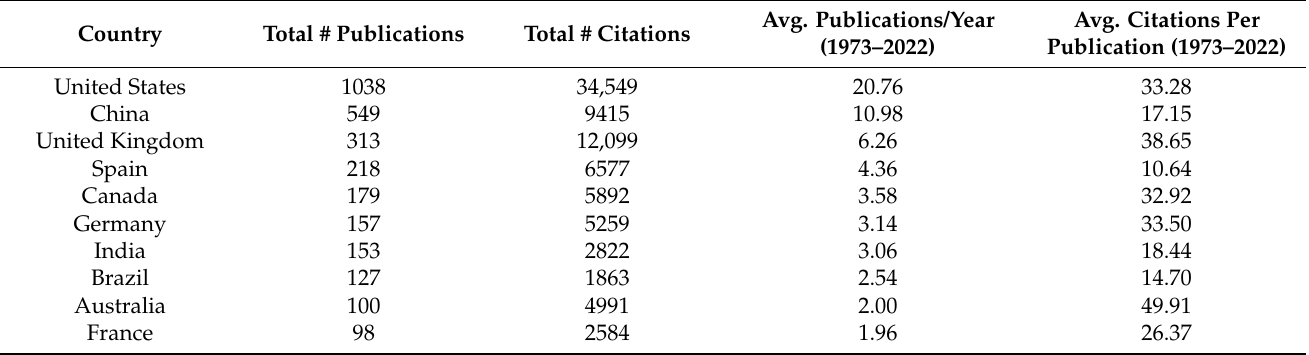
Table 3. Global research trends 1973–2021 by number of publications, number of citations, average publications per year, and average citations per publication.